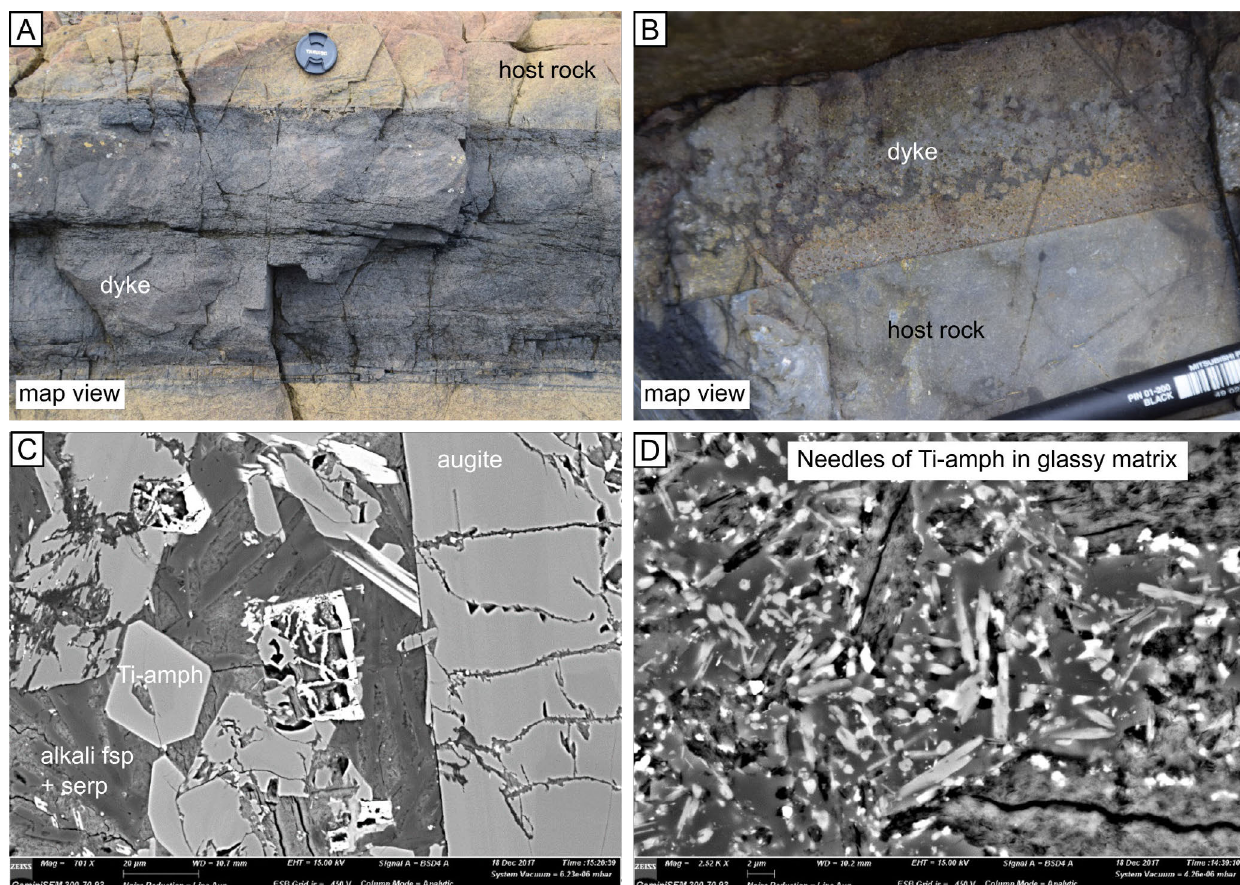
Figure 5: Details of the textures and mineralogies of the dykes at Birsay. [A] Photograph (map view, N at the top) showing a typical profile across Dyke 1, with chilled margins and a central core zone that often appears vesicular in the field (lens cap is 6.5 cm across). Note the discolouration of the host rock in the baked margin. [B] Photo- graph (map view, N at the top) showing details of a complex, probably composite, chilled margin within Dyke 1 (pen is 1 cm across). [C] SEM-BSE image of a thin section from the core of Dyke 1. The groundmass is made up of alkali feldspar and serpentine after olivine (occasional relics preserved). The phenocryst cargo includes Ti- rich amphibole (probably kaersutite) and zoned augite. Other phases include Mn-rich calcite, dolomite, quartz, Ni-rich pyrite and Cr-spinel. [D] SEM-BSE image of a thin section a chilled margin of Dyke 1 showing needles of Ti-rich amphibole in a glassy